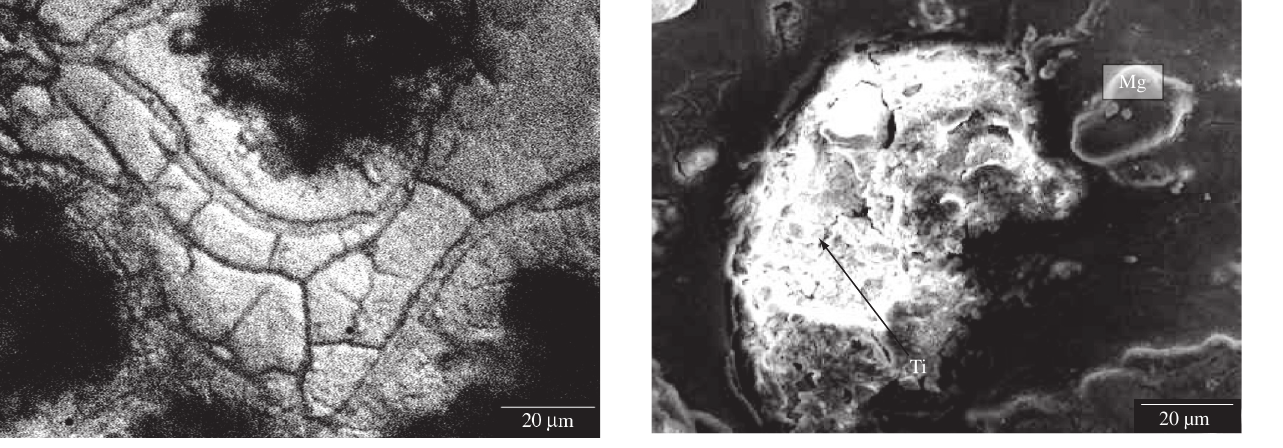
Figure 5. Microstructure in the DRX domain of 0.1 s -1 and at 450 °C. Figure 7. SEM image of particle breakage observed at 300 °C, 1.0 s -1 .